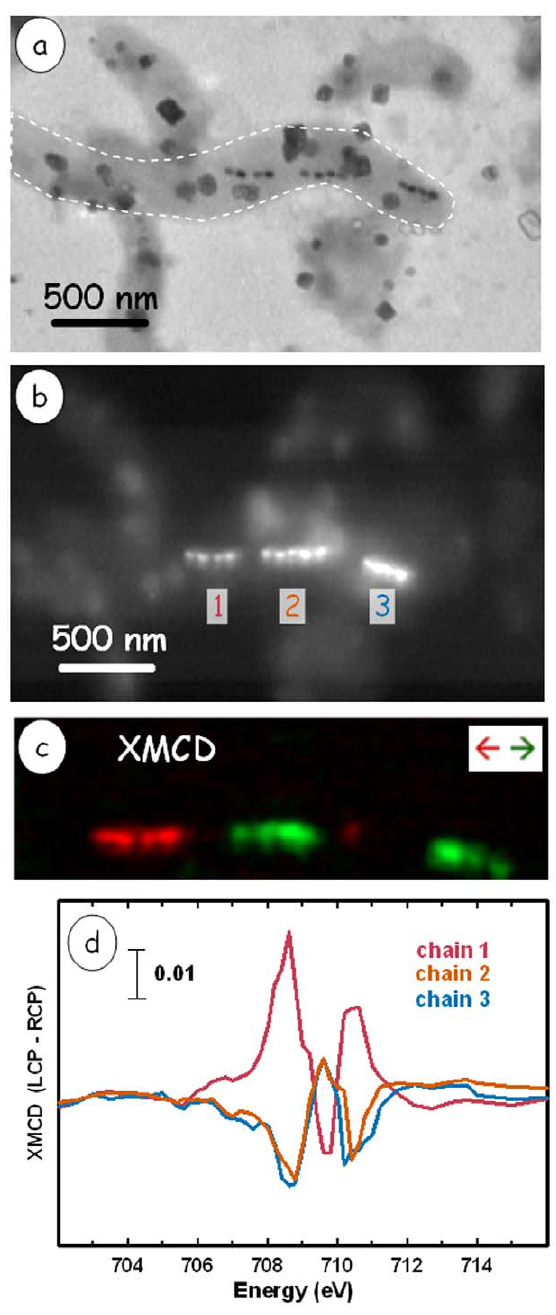
Figure 4. XMCD of an MV-1 cell showing gaps in the magnetosome chain. (a) TEM image of the cell. The rectangular dark objects are salt crystals from the growth medium. The dashed white line indicates the boundary of the cell which contains 3 sub- chains. (b) STXM image at 709.8 eV of the identical region. (c) Color coded composite of the XMCD signal from the magnetosome chain. (d) XMCD spectra of the 3 subchains.